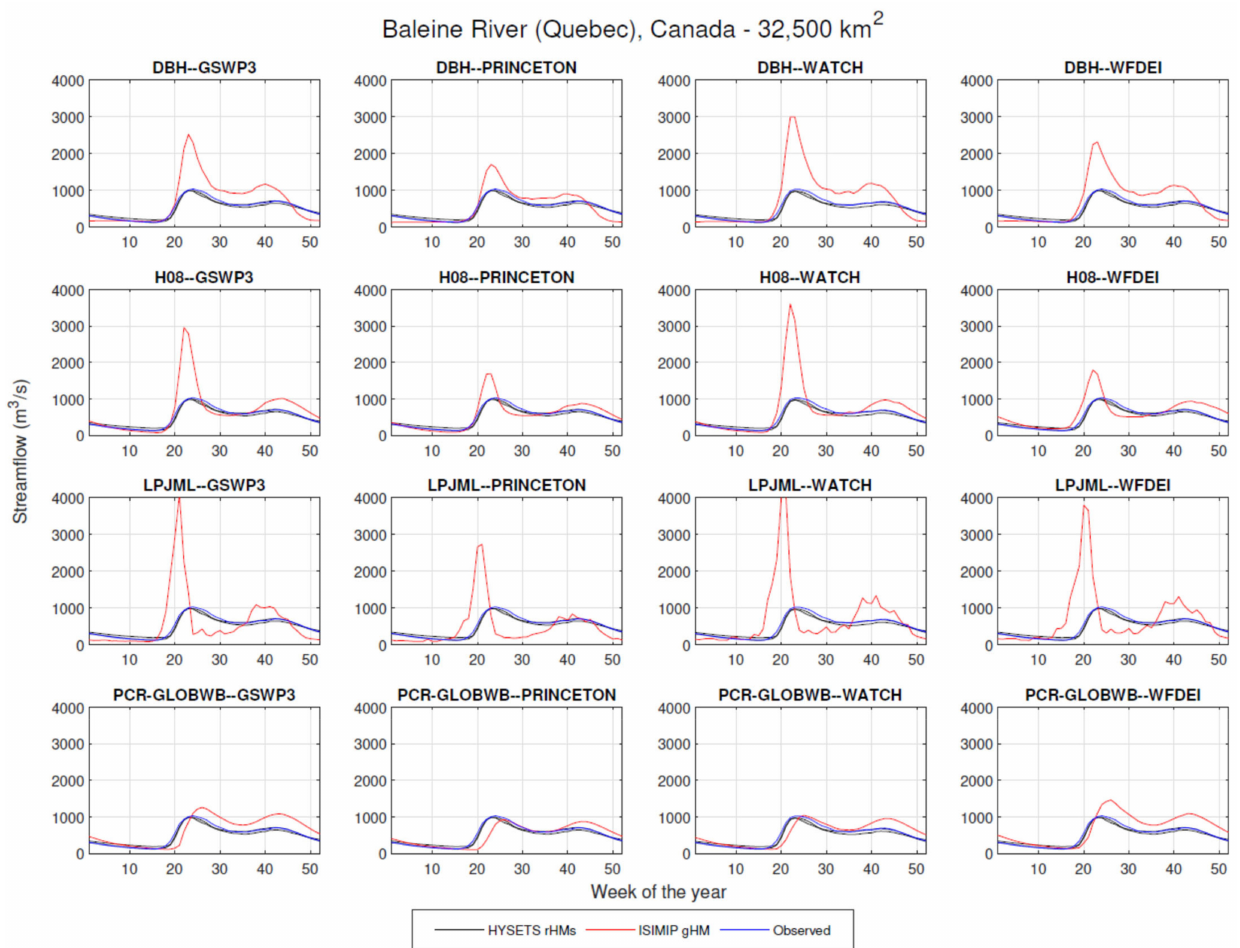
Figure 9. Observed (blue curve) and simulated weekly catchment-scale discharge for the Baleine River Basin in Quebec (Canada; S = 32,500 km 2 ) by the 16 gHM–climate–dataset combinations (red curves) and the two rHMs (black curve) over the 1971–2010